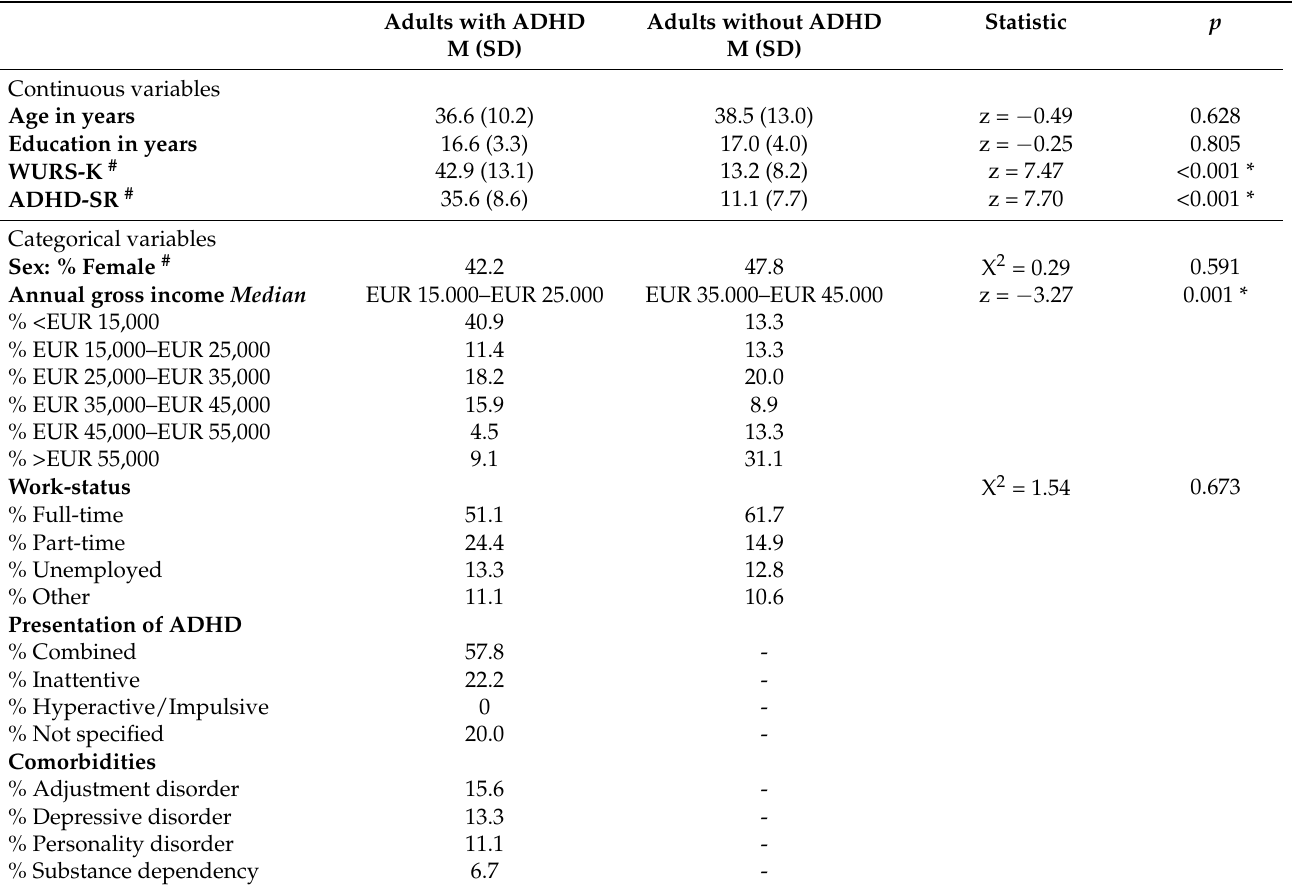
Table 2. Descriptive and clinical characteristics of adults with ( n = 45) and without ADHD ( n = 47). Adults with ADHD Adults without